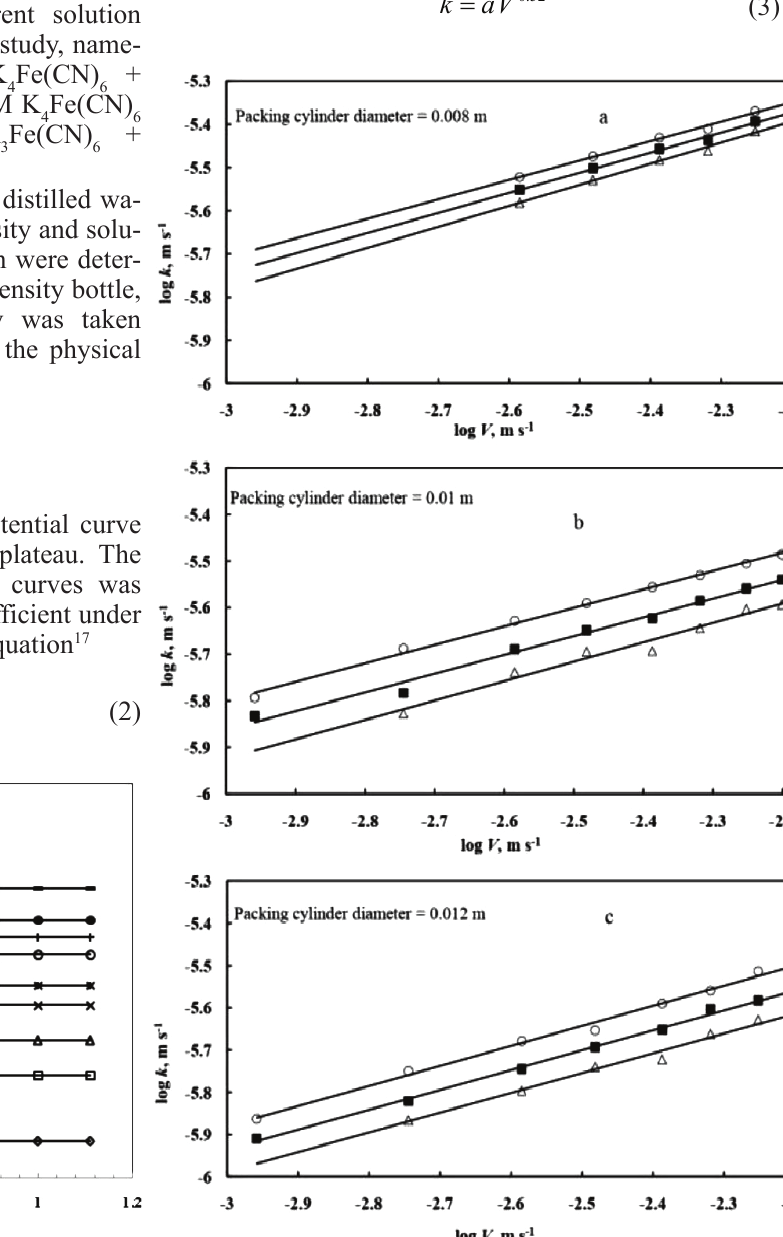
Fig. 2 – Typical polarization curves at different solution ve­ locity (coil tube diameter = 0.01 m, packing cylinder diameter = 0.008 m, Sc = 1821)